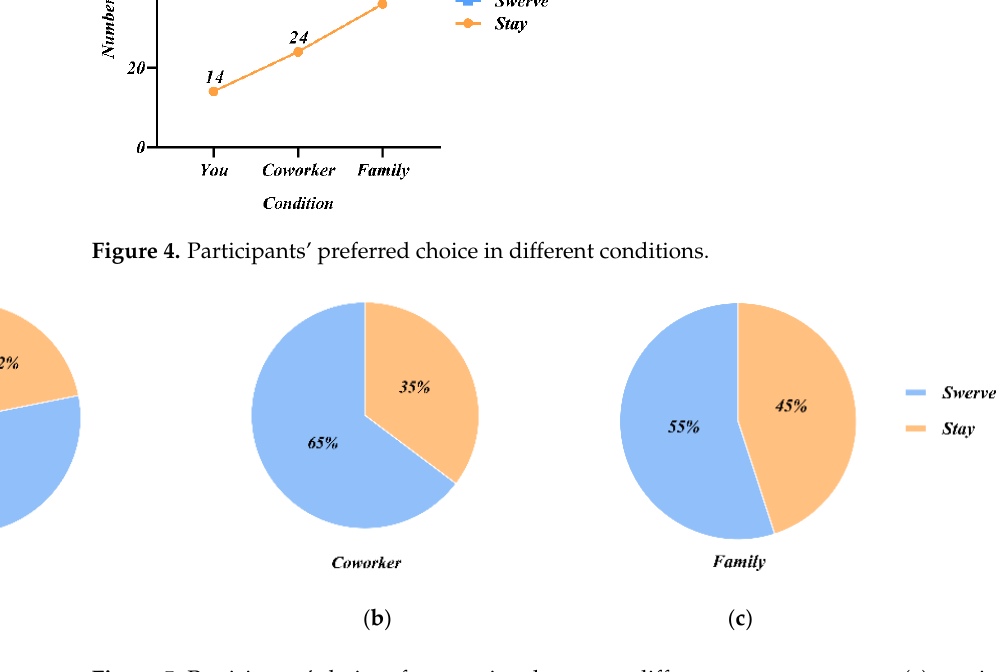
Figure 5. Participants’ choice of proportional sector at different passenger status. ( a ) you in the AV; ( b ) your coworker in the AV; ( c ) your family member in the AV.